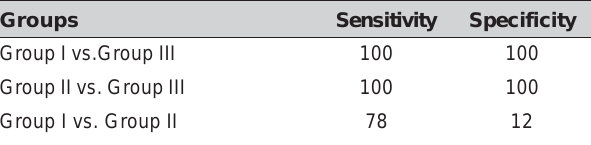
Fig. 7 - Lysis of connective tissue H&E –